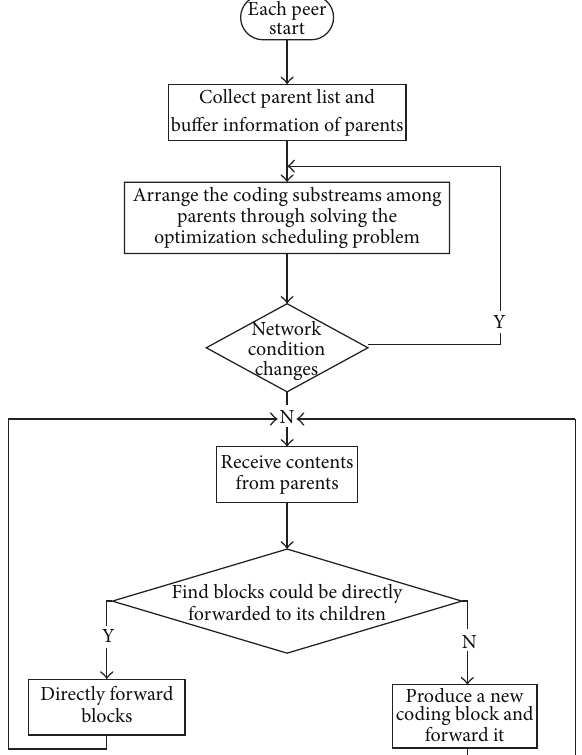
Figure 4: The flowchart of our QoS driven scheduling approach.